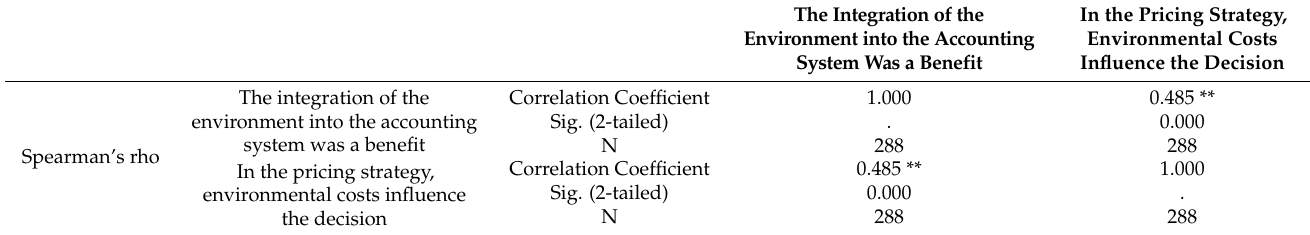
Table 14. Spearman’s rank correlation for the variable environmental benefits in the accounting system * decision to integrate environmental costs into the product